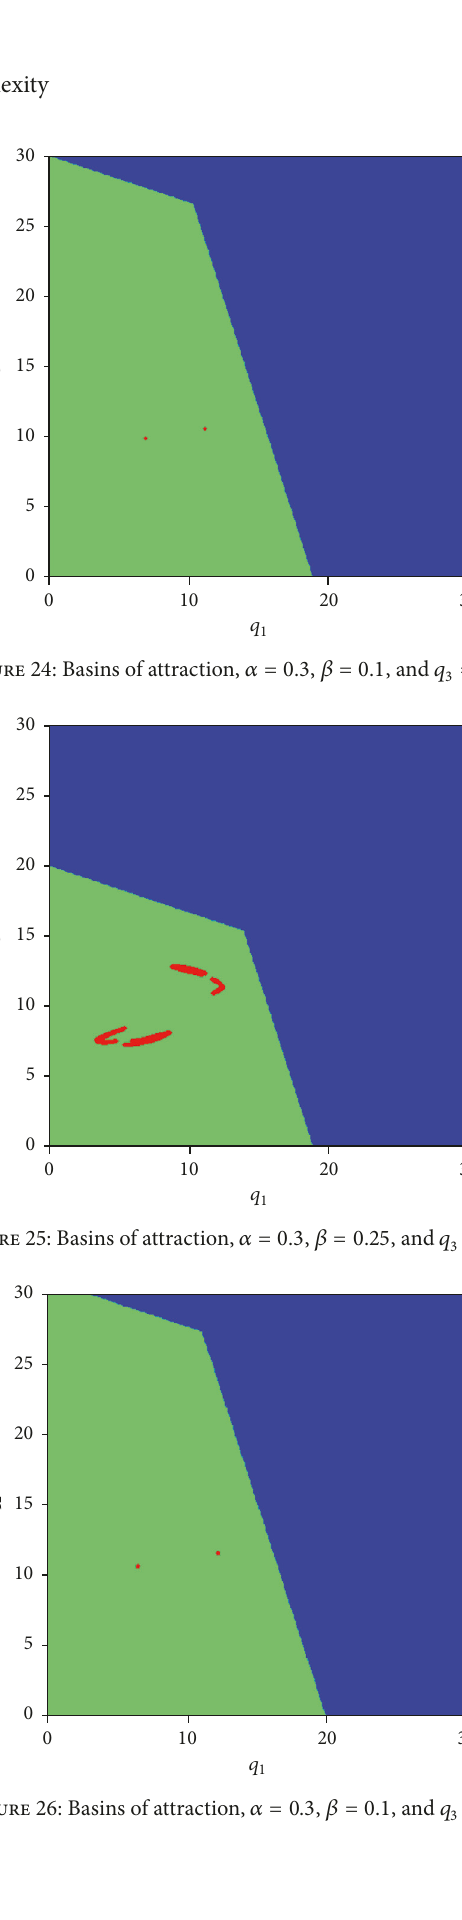
Figure 26: Basins of attraction, 𝛼 = 0.3 , 𝛽 = 0.1 , and 𝑞 3 = 7 .